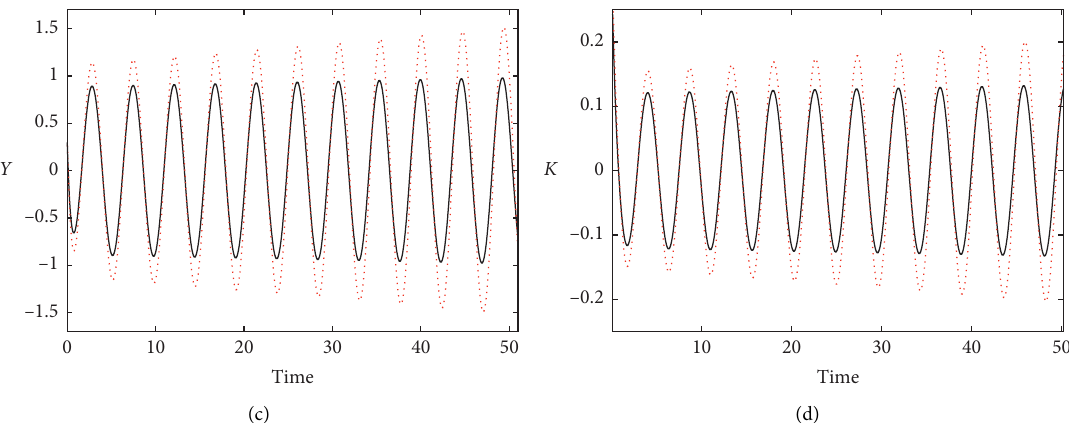
Figure 10: The business cycle of gross product Y and capital product K versus time t is plotted. The analytical outcome of the two terms and the numerical scheme of the PDE model are